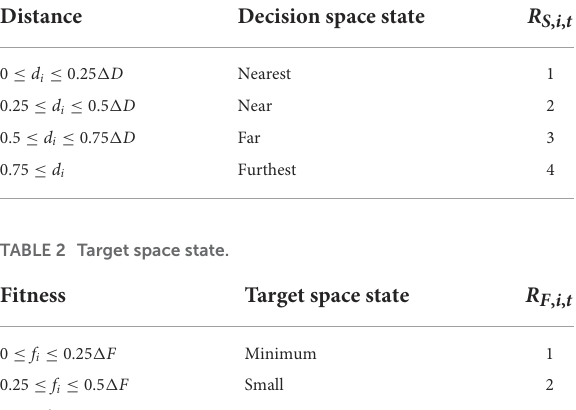
TABLE 1 Decision space state.